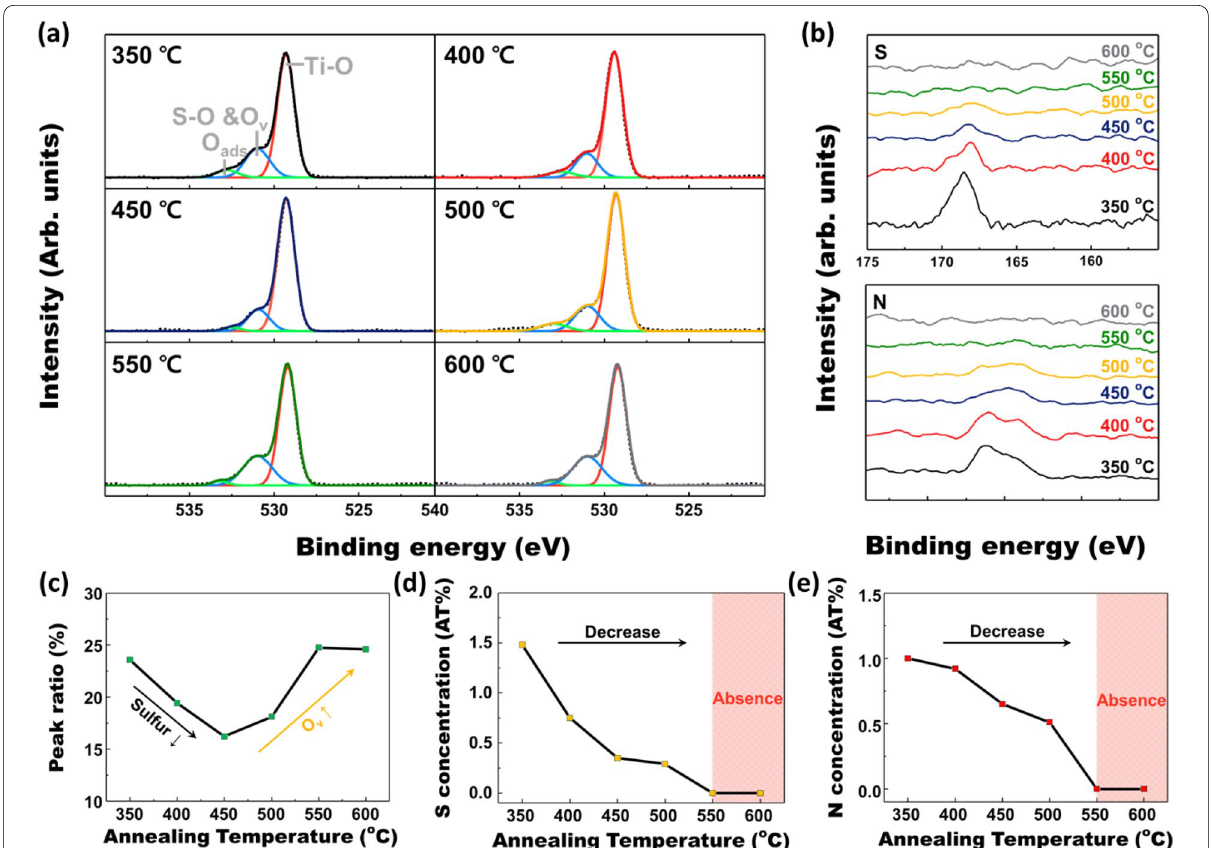
Fig. 5 Elemental analysis by XPS spectra. a O 1 s, bb S 2p and N 1 s peaks for the S, N-doped TiO 2 nanorod arrays under various H 2 treatment conditions. c Change of peak volume ratio (S–O and O v /Ti–O) for H 2 annealing temperature. d Sulfur and e nitrogen dopant concentration change for